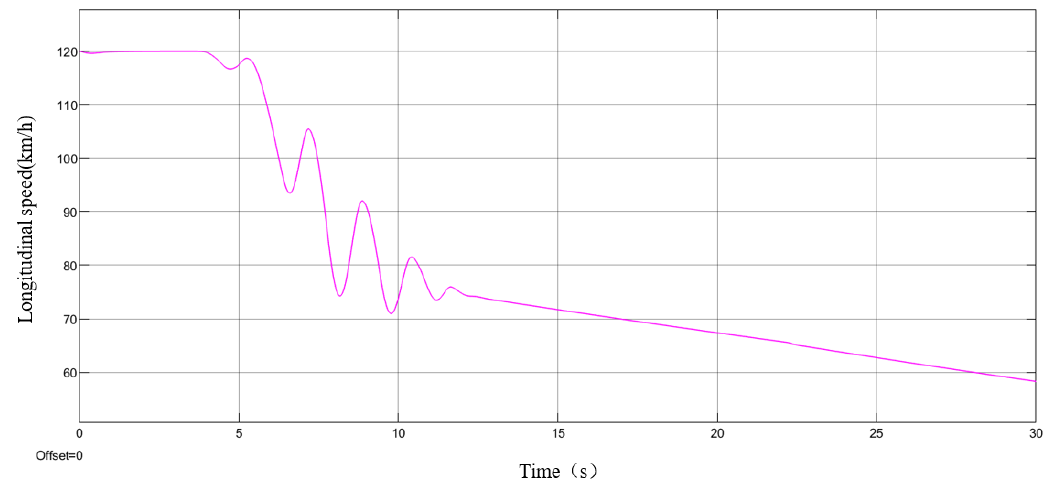
Figure 11. Longitudinal speed variation curve for double lane-change test.